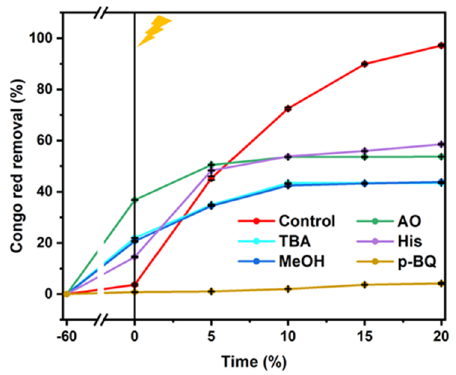
Figure 9. Effect of radical scavengers on the removal of CR in the CMO-8/PDS system (conditions: 100 mg·L − 1 CR, 1 g·L − 1 catalyst, 0.5 mM PMS and pH of 7). The error bars represent the standard deviation (n = 3).